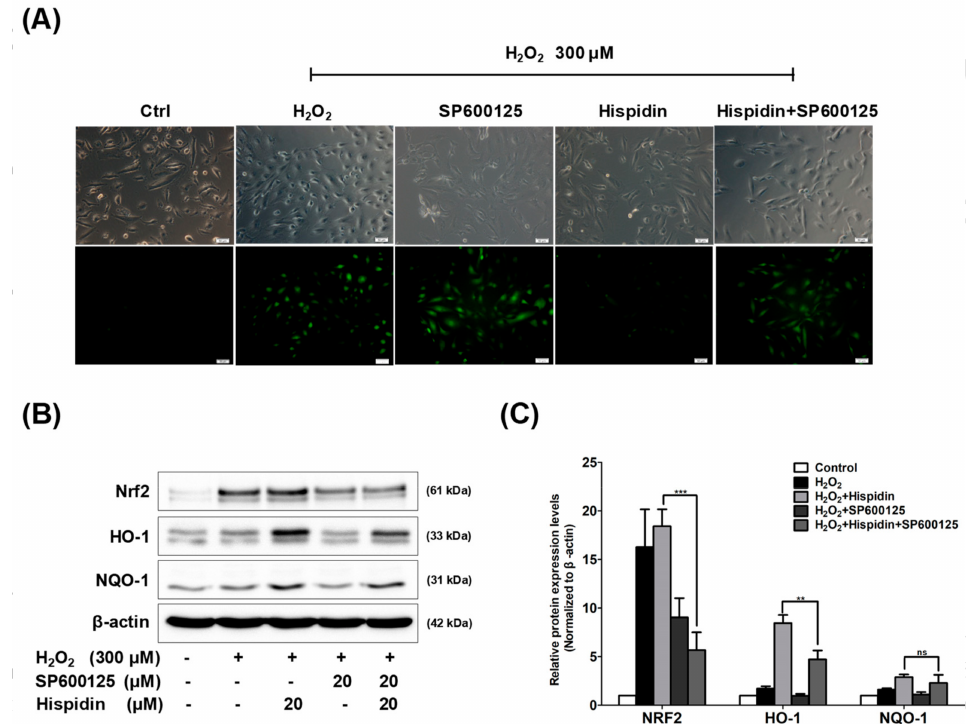
Figure 5. The role of JNK activation in hispidin-induced Nrf2 signaling on ARPE-19 cells. ( A ) Cells were pre-treated with 20 µ M hispidin, 20 µ M SP600125, or both for 24 h and then treated with 300 µ M H 2 O 2 for 6 h. The ROS generation was measured by dichlorofluorescin diacetate (DCFDA) assay. The green fluorescence represents the cells stained for ROS (magnification 200 × ). ( B ) Cells were pre-treated with 20 µ M hispidin or 20 µ M SP600125 for 24 h followed by 300 µ M H 2 O 2 treatment for 24 h. The expression levels of Nrf2, HO-1, and NQO-1 were evaluated by Western blot. ( C ) Quantitative analysis was performed by measuring the intensity relative to the control. ** p < 0.01, *** p < 0.001, ns: not